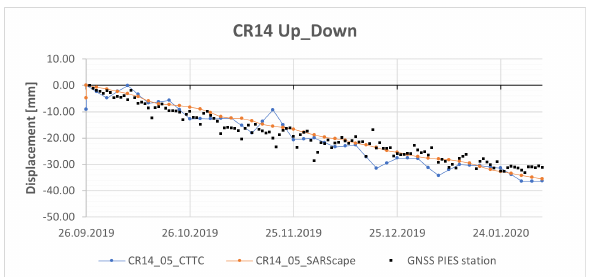
Figure 13. The CR14 vertical displacements determined by PSI and GNSS measurements